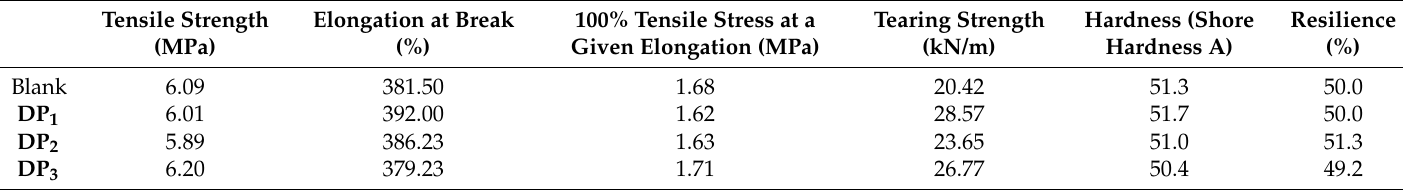
Table 4. Static mechanical properties of rubbers colored with purple silicon-containing reactive disperse